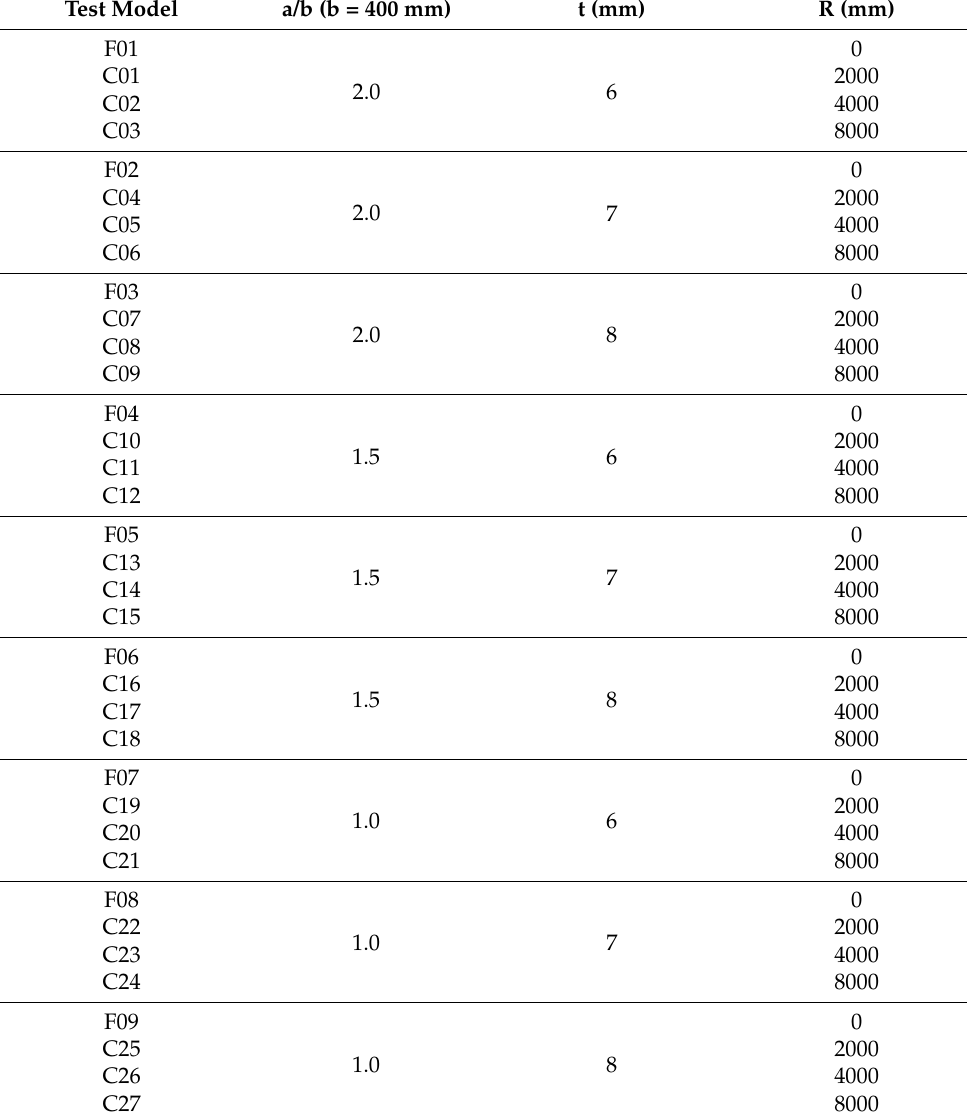
Table 1. Experimental scenario.